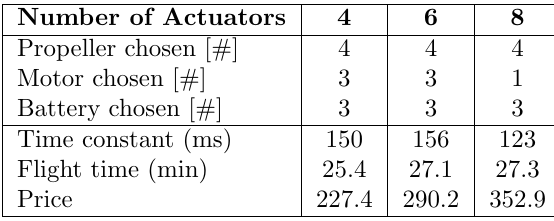
Table 9: Optimization Results: Test Case II.